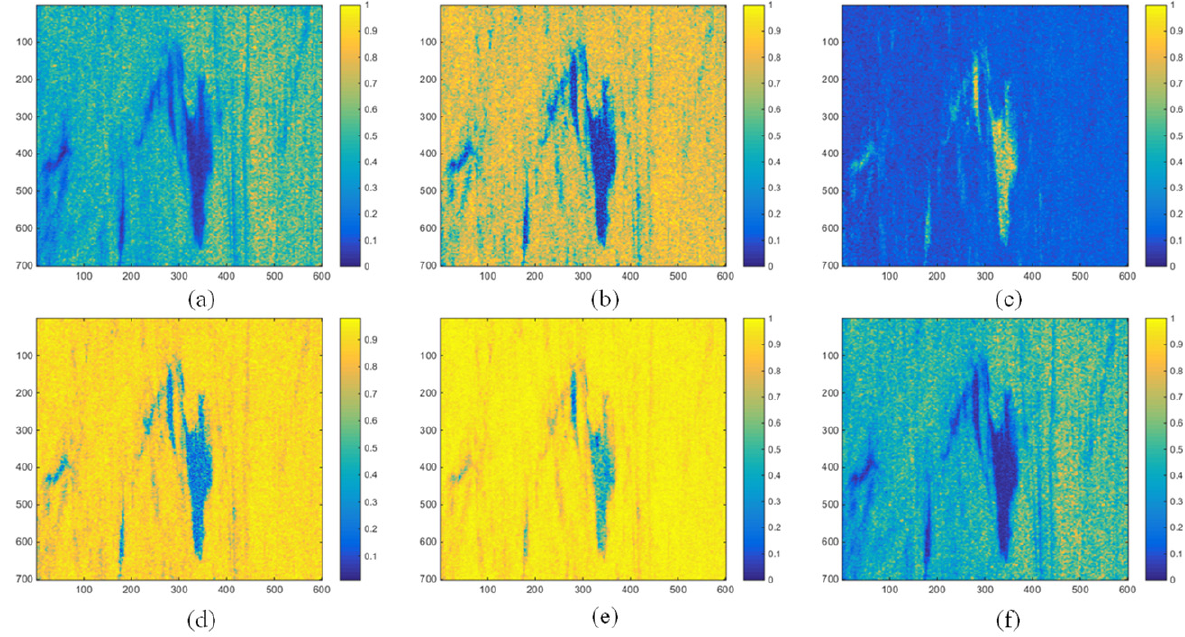
√ g 0 ; ( b ) 1 − H w ; ; ( b ) 1 − 𝐻 ; ( c ) (cid:3050) 0